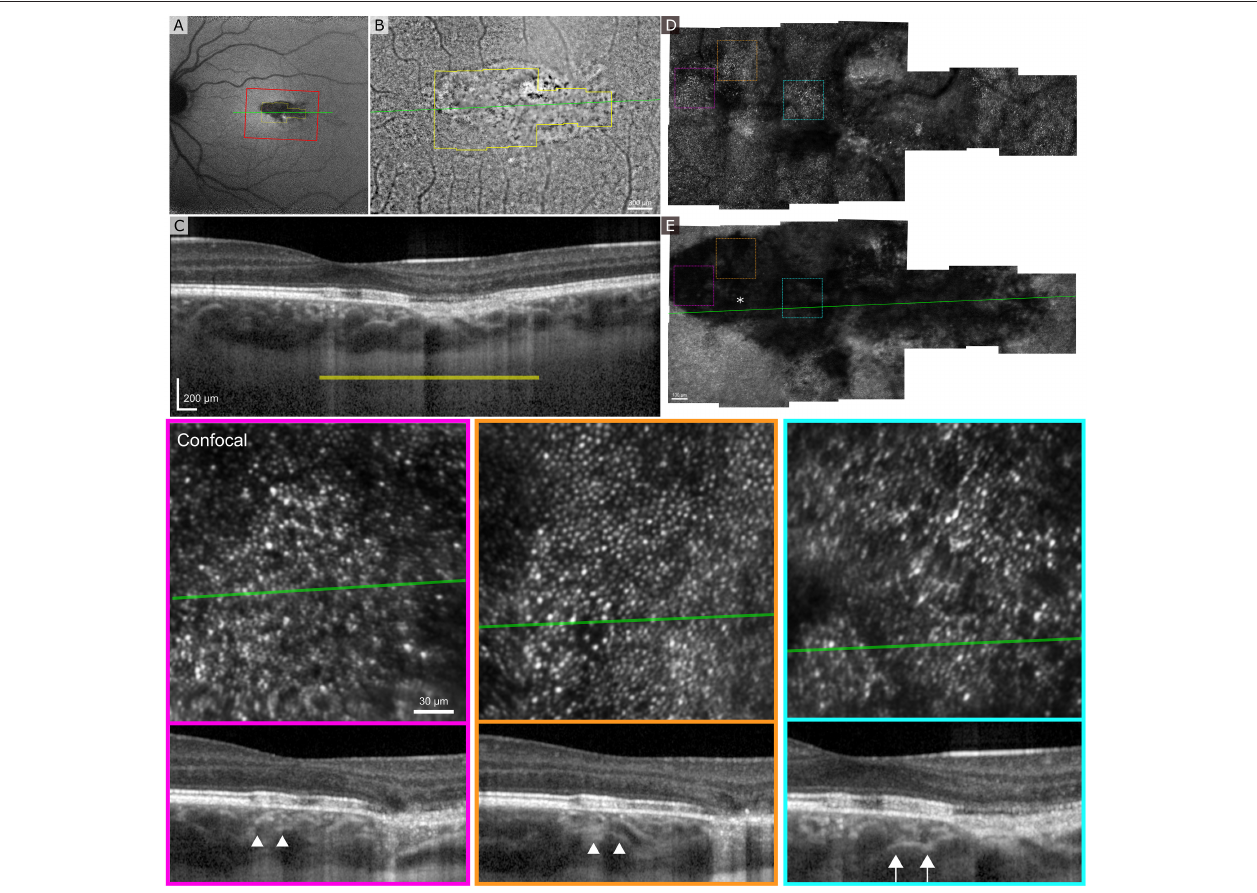
FIGURE 5 | Adaptive optics ophthalmoscopy imaging of the patient 2. (A) A clinical SLO reflectance image showing the location of the FIAO montage with red box and OCT B-scan with a green line going through the lesion. (B) FIAO montage showing typical photoreceptor mosaic outside the lesion. The yellow outline indicates the area imaged using AOSLO, with yellow bar showing the FIAO image location in the OCT B-scan. (C) B-scan showing extensive damage at the RPE layer with slightly increased light penetration to the choroid. (D) Confocal AOSLO montage of the lesion area. Compared to FIAO, the cone mosaic is sharper and has more contrast due to confocality and rejection of out-of-focus light. Even within the lesion patches of photoreceptor mosaic are seen. (E) AO-IRAF shows highly reduced FAF from the lesion throughout, even within areas where the photoreceptor mosaic seemed healthy, suggesting that the RPE underlying the photoreceptors is damaged. The colored dashed squares mark the location of the zoomed in areas at the bottom with colors indicating the areas. The B-scan locations are marked with a green line and in the B-scans the white arrow heads show the edges of the zoomed in area. The location of the fovea is marked with an asterisk in (E)